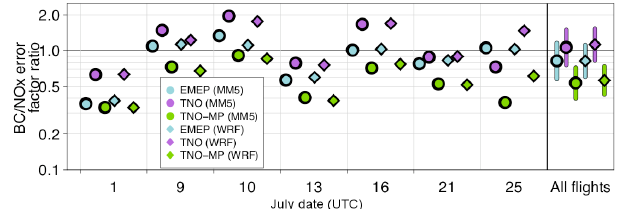
Figure 8. BC / NO x EEF ratio for each individual flight and aver- aged for all flights (on the right) with confidence interval, for all six simulated cases (logarithmic